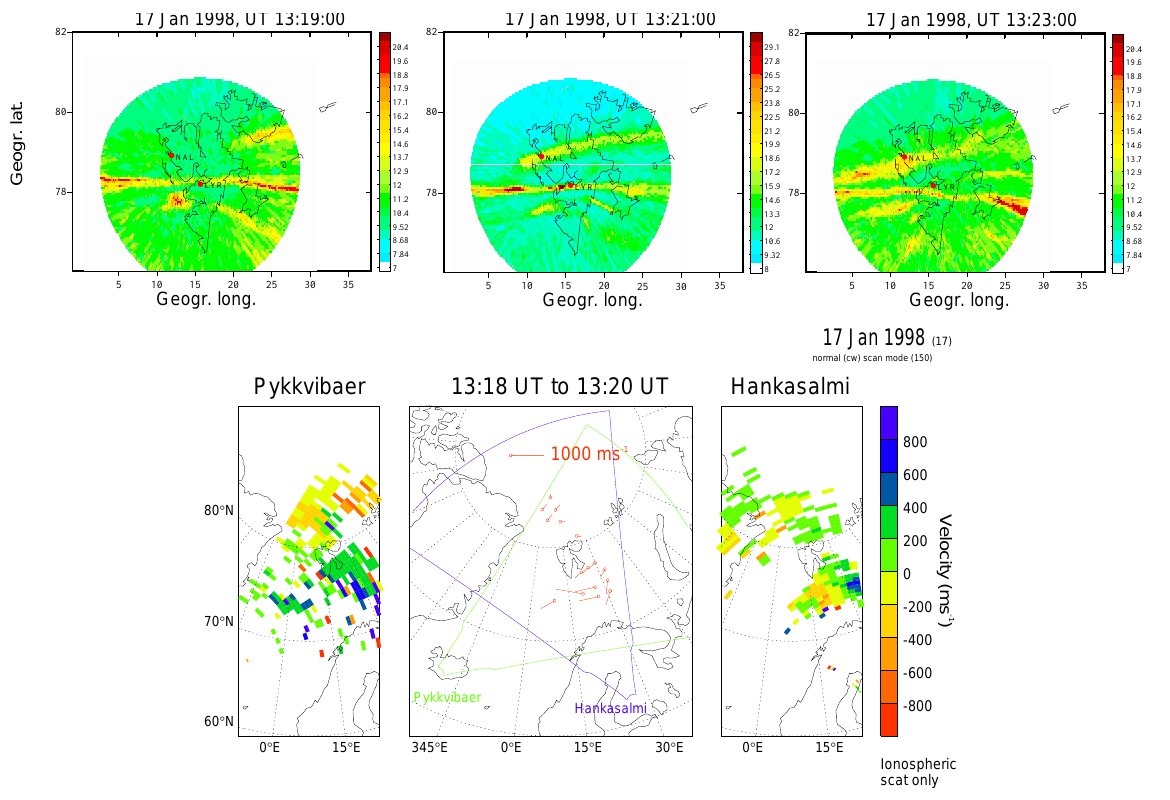
Fig. 11. Three ASC images (557.7nm emission in ADUs, assumed to be at 110km altitude) acquired at LYR on 17 January 1998, at 13:19, 13:20, and 13:23 UT and ionospheric plasma flow direction as observed by the CUTLASS radar system (plots in the bottom row). In the bottom row, the left (right) side plot shows the line-of-sight velocity of the Iceland (Finnish) radar. Positive velocities are towards the radar. The middle plot shows the actual velocity vectors as derived by combining the data of the two